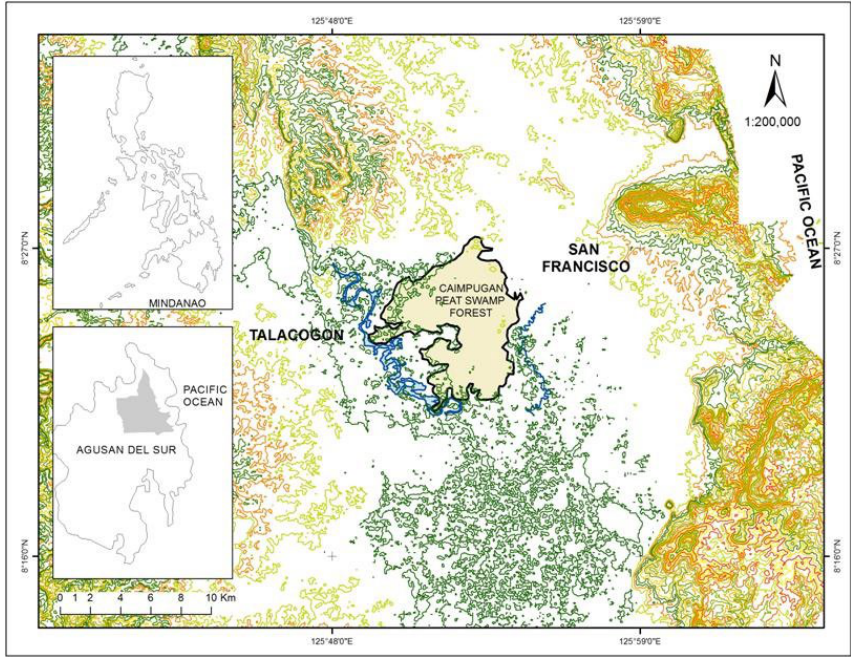
Fig. 1: Map of the study site